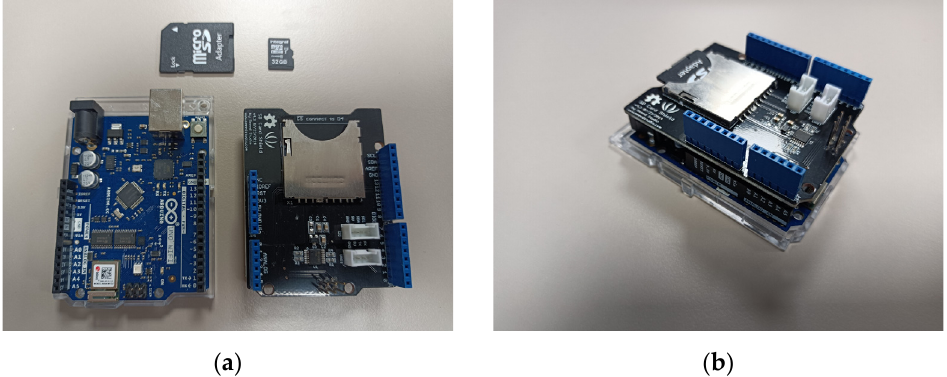
Figure 12. ( a ) Arduino WiFi R2 board on the left, SD card shield on the right, micro SD ‐ card and its adaptor; ( b ) all elements from ( a ) assembled. Equipment: SD card shield from Seeed Studio, micro SD ‐ card 32Go.